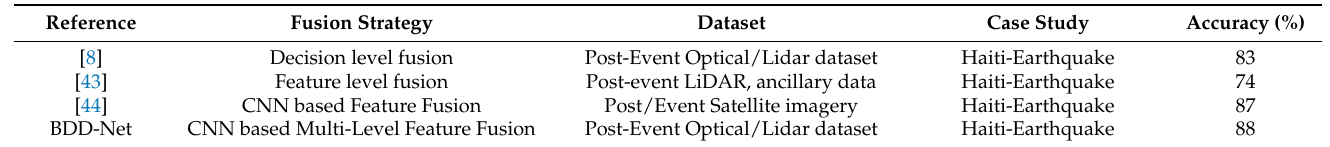
Table 8. The comparison of numerical results from BDD is based on fusion strategies for the Haiti-